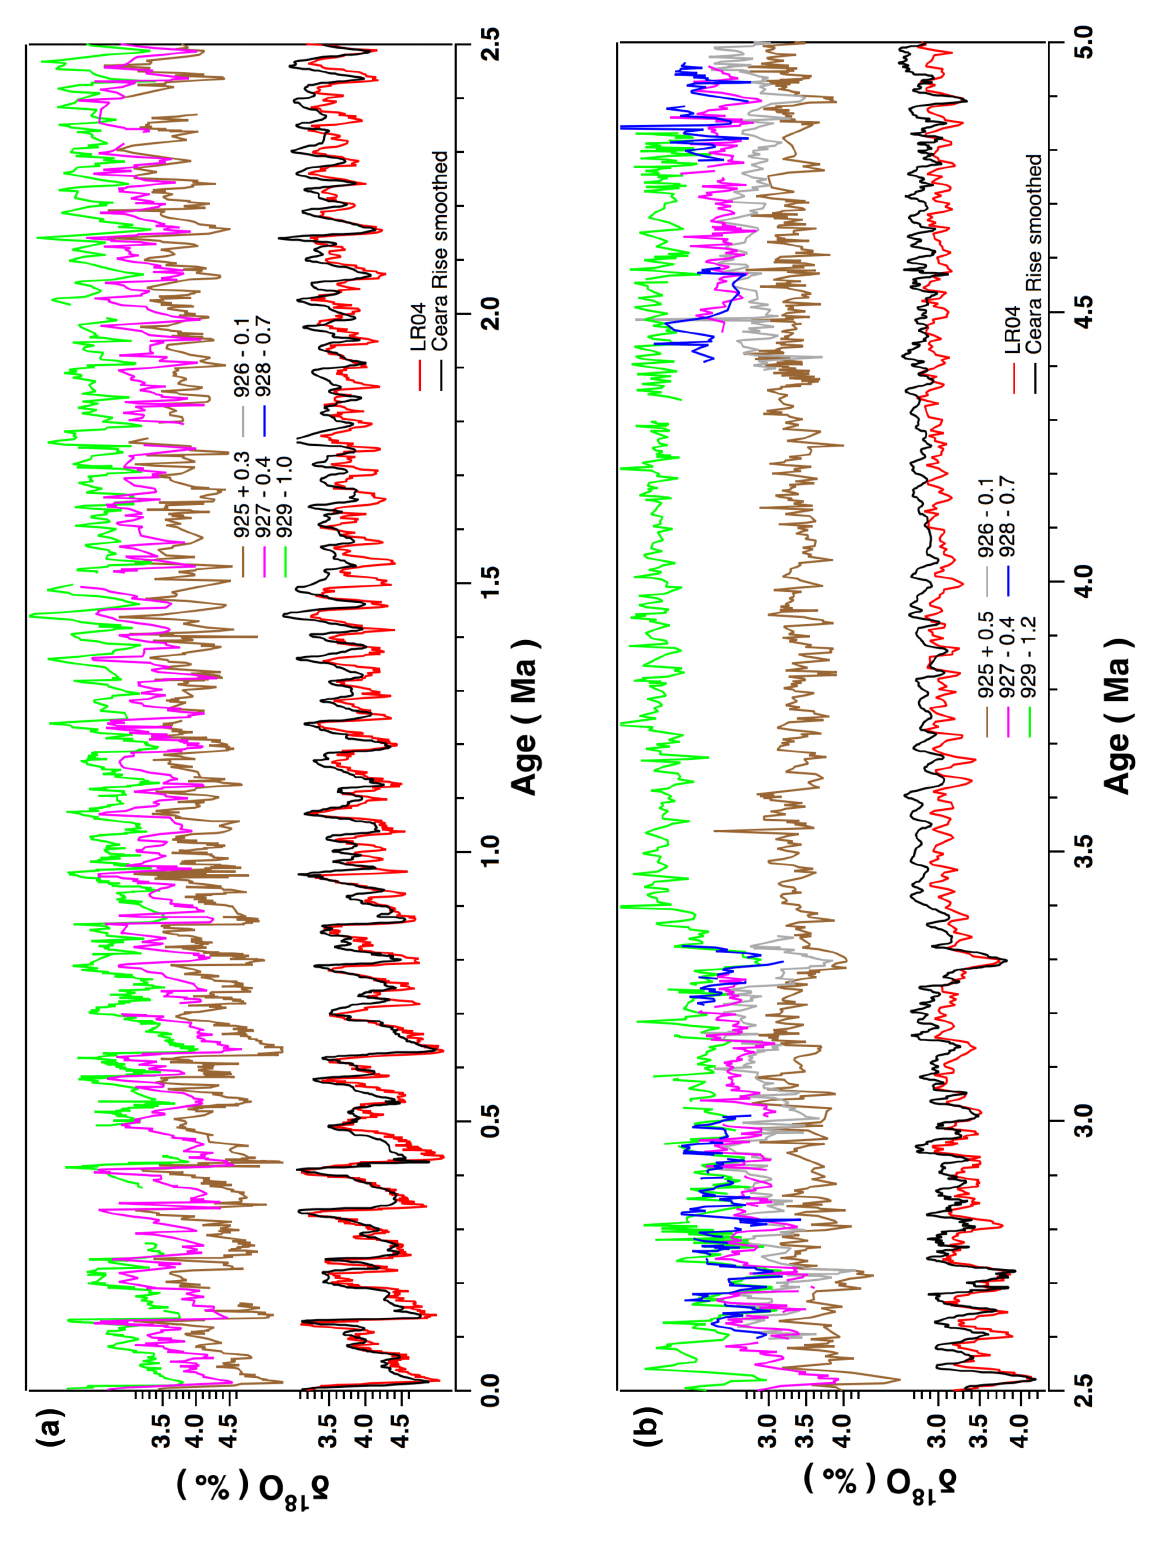
Figure 8. Benthic oxygen isotope data from all Ceara Rise sites compared with one another and a smoothed composite of all data compared to LR04. (a) 0 to 2.5Ma; (b) 2.5 to 5Ma. Note the δ 18 O scale change between (a) and (b) . Individual site traces have been offset as indicated in the